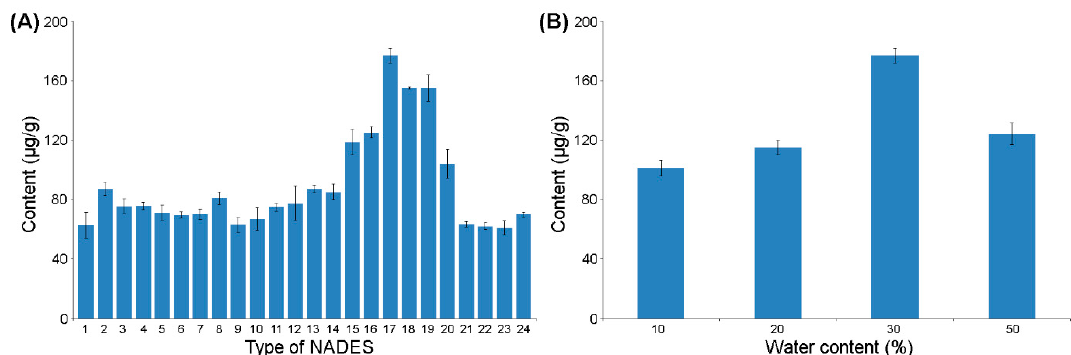
Figure 2. Effect of NADES type ( A ) and water content ( B ) on 20-E extraction efficiency from spinach. Figure 2. E ff ect of NADES type ( A ) and water content ( B ) on 20-E extraction e ffi ciency from Each NADES contained two or three compounds but at least one of the components is a carboxylic acid (lactic, malic, levulinic, tartaric, citric, or pyruvic acids). The pK a values of acids were